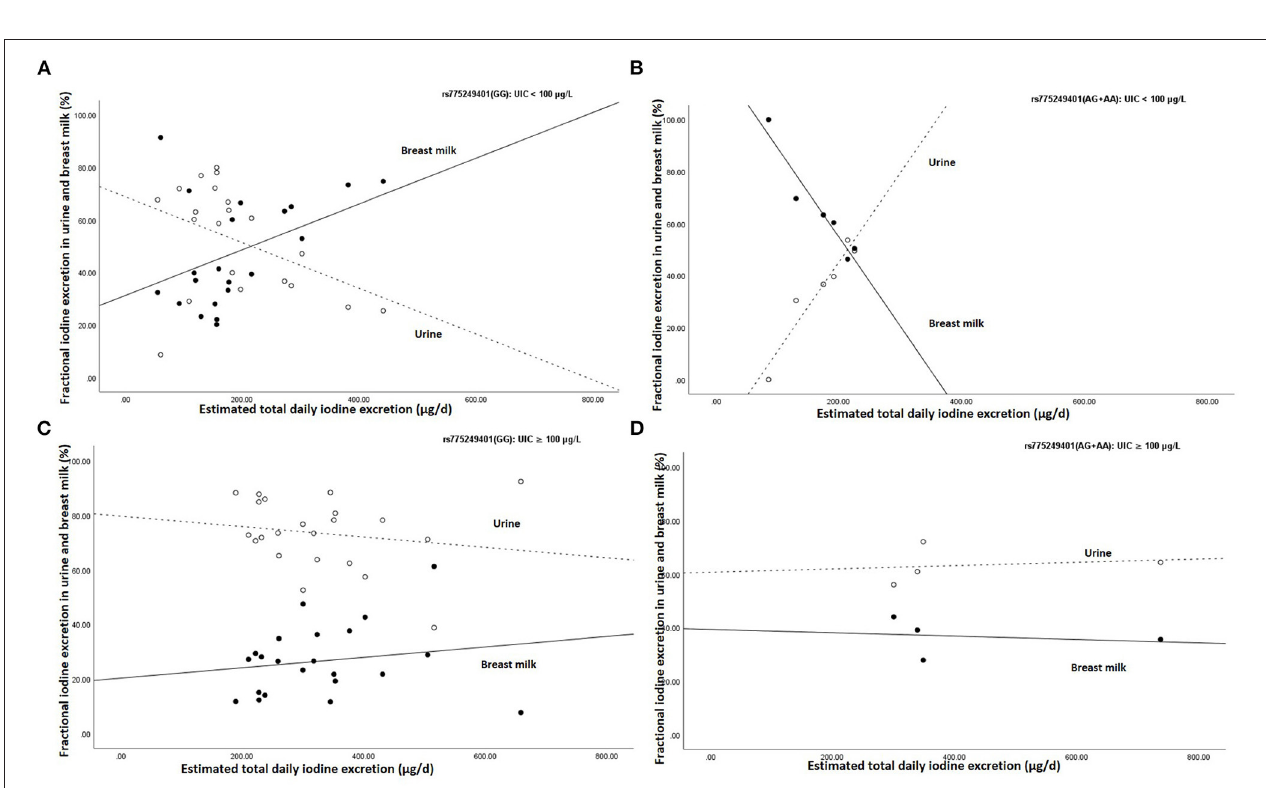
FIGURE 1 | Association between estimated daily iodine excretion and fractional iodine excretion in breast milk and urine for (A) the homozygous G group ( n = 43) and (B) the (A) allele carriers (AA + AG) ( n = 10). The open data points represent fractional excretion of iodine in urine and the filled data points, the fractional excretion in breast milk. The dotted line is the regression line for fractional excretion of iodine in urine. The solid line is the regression line for fractional excretion of iodine in breast milk.